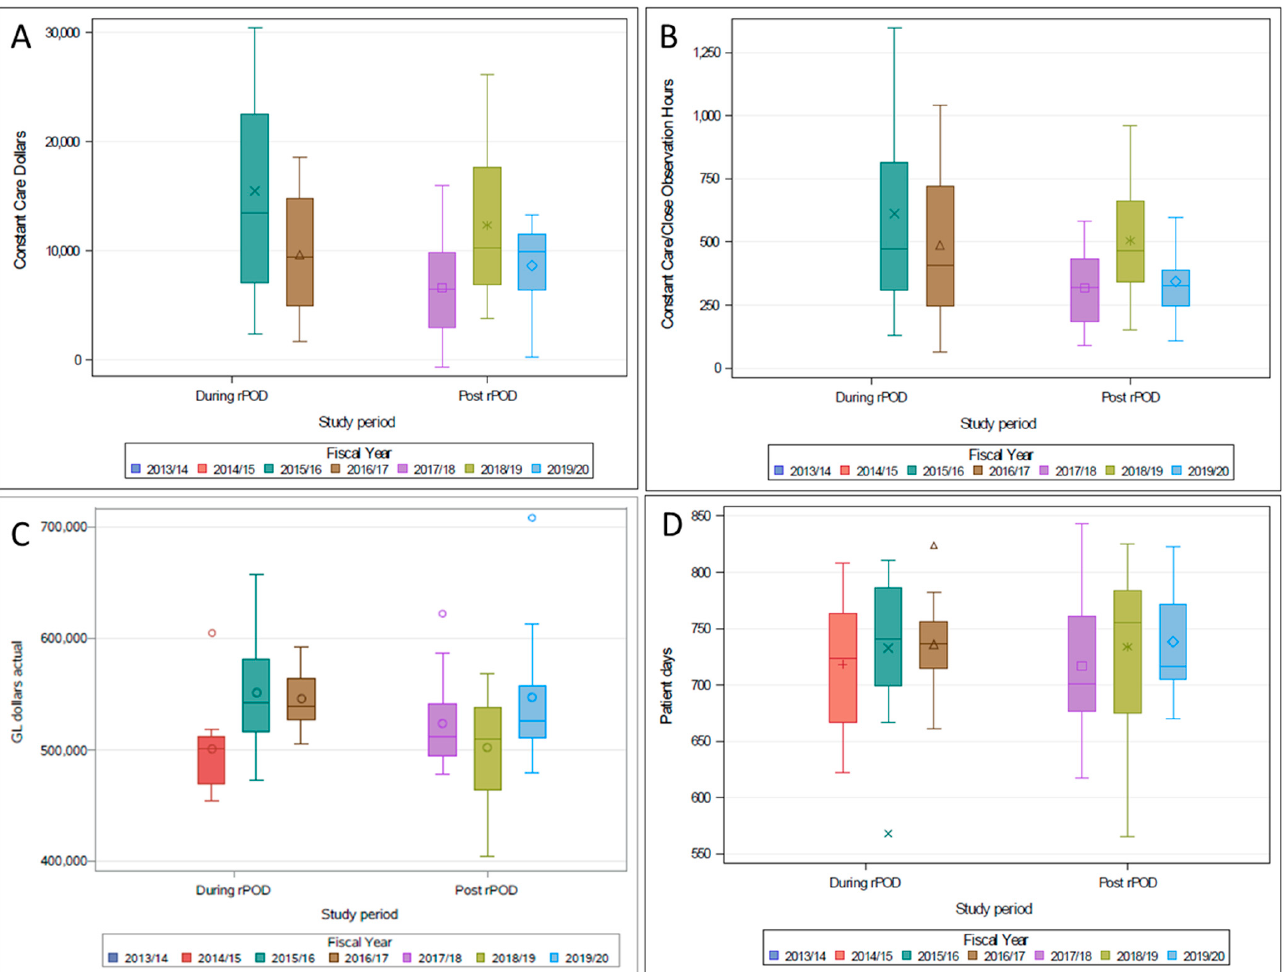
Figure 2. The fiscal trends during (2013–2016) and following (2017–2020) rPOD intervention. Panel ( A )—Constant care expenditure by study period, Panel ( B )—Constant care observation by study period. Panel ( C )—Gross expenditure by study period and Panel ( D )—In-patient days by study period. The financial data was collected from the administrative database with the cardiac science program.